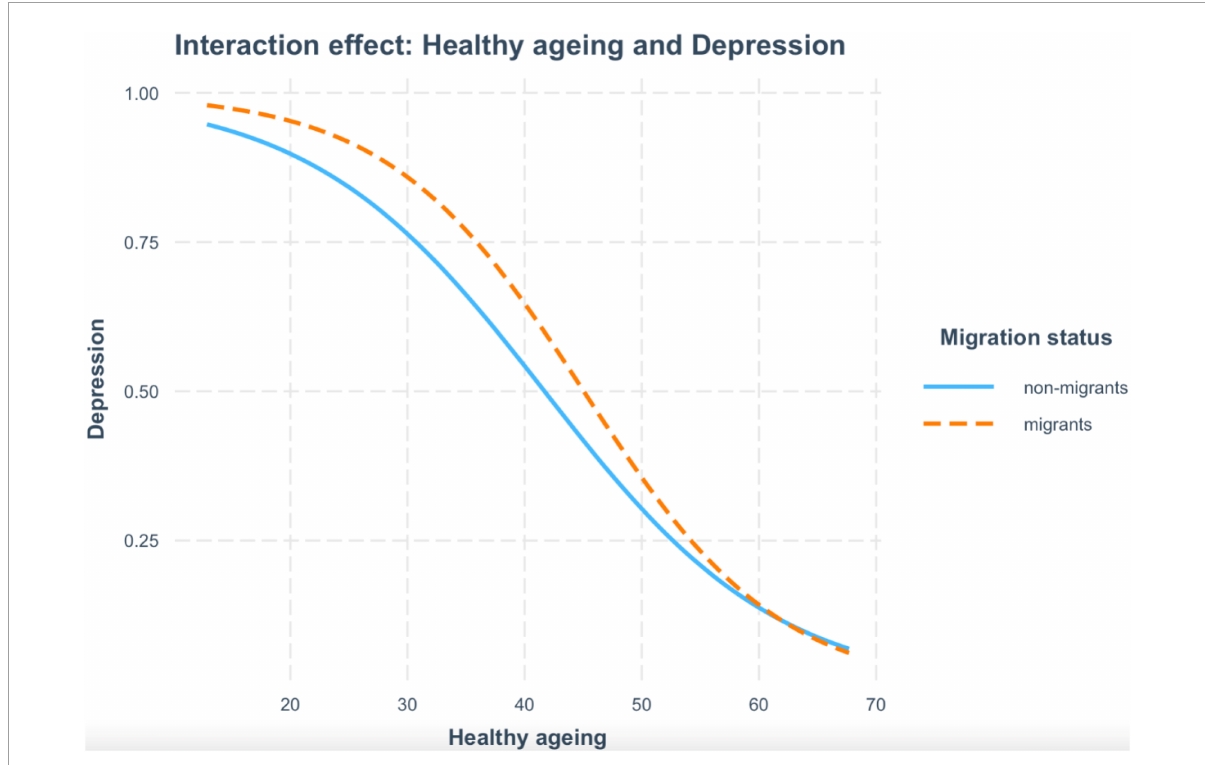
FIGURE1 According to migration, the figure depicts the interaction between healthy aging and depression symptoms. The orange dashed line corresponds to migrants, and the blue line corresponds to